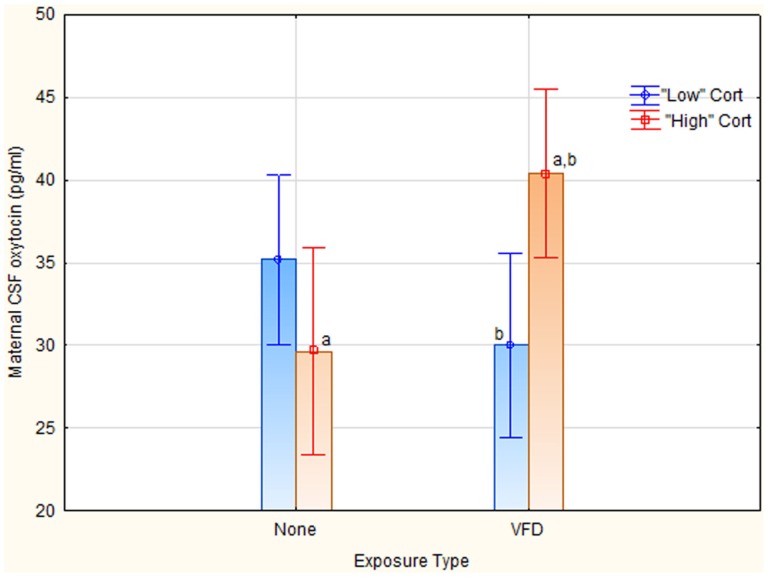
Relationship between maternal plasma cortisol grouping to maternal CSF OT concentrations as a function of VFD exposure. We dichotomized, using a median split, maternal plasma cortisol into “high” versus “low” plasma levels [“high” cortisol mean (SD) = 48.96 (3.57) ng/ml (N = 10) versus “low” cortisol mean (SD) = 39.16 (3.84) ng/ml (N = 11); t-value = −6.02;df = 19; p = 0.000008]. Two cortisol values lacking matching OT values were excluded. Using a factorial ANOVA GLM with OT as the dependent variable, and cortisol grouping and VFD exposure as categorical variables, there was no VFD exposure effect, or cortisol grouping effect but a VFD exposure × cortisol grouping interaction was noted [F(1; 17) = 9.23, p = 0.007]. Post hoct-test differences (p ≤ 0.05) for CSF OT; aVFD-exposure high-cortisol grouping > non-exposed high-cortisol grouping; bVFD-exposure high-cortisol grouping > VFD-exposure low-cortisol grouping. Vertical bars denote 0.95 confidence intervals.